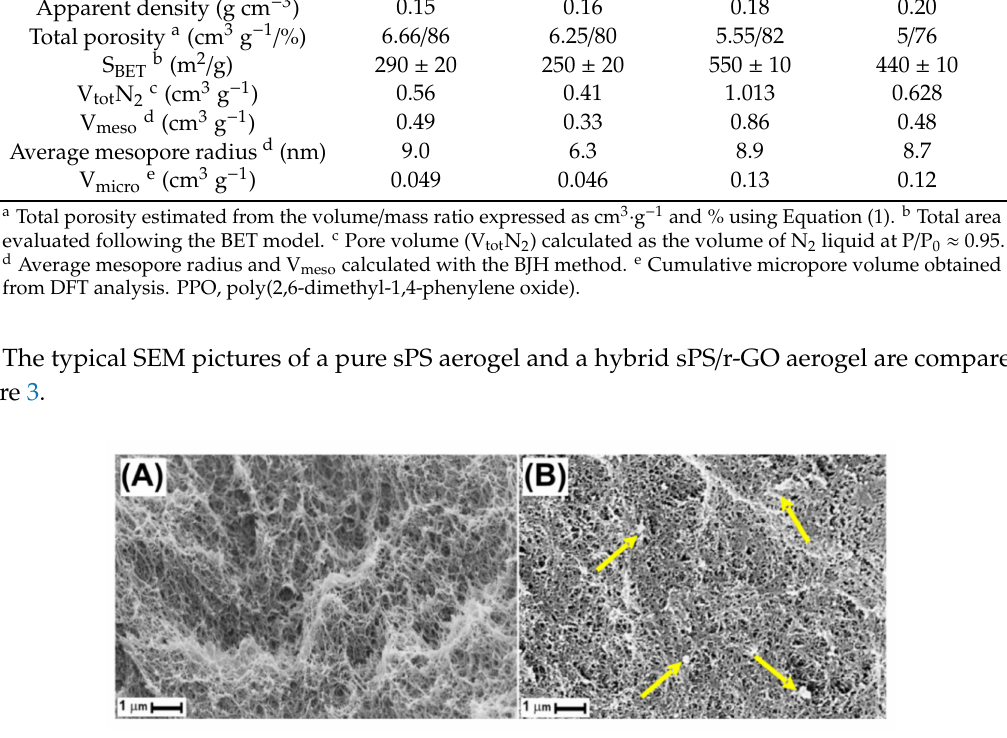
Figure 3. SEM images of the morphology of the monolithic pristine sPS aerogel ( A ) and of the hybrid sPS / r-GO aerogel obtained after scCO 2 solvent extraction ( B ). Some r-GO particles dispersed in the hybrid aerogel are indicated by yellow